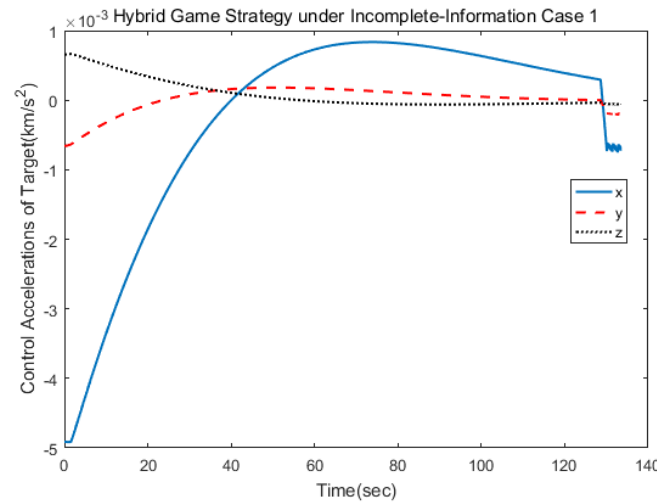
Figure 6. Control acceleration of the target.